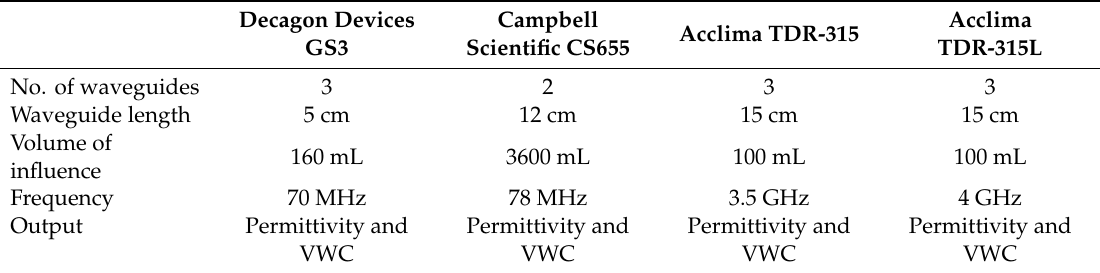
Table 1. Description of electromagnetic soil moisture sensors. Sensors varied in waveguide length, number of waveguides, volume of influence and frequency. The TDR-315 and TDR-315L are nearly identical and were grouped for this